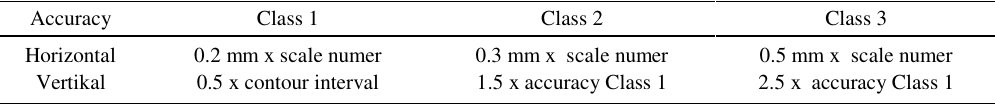
Table 2. Geometrical Accuracy of RBI-maps according to